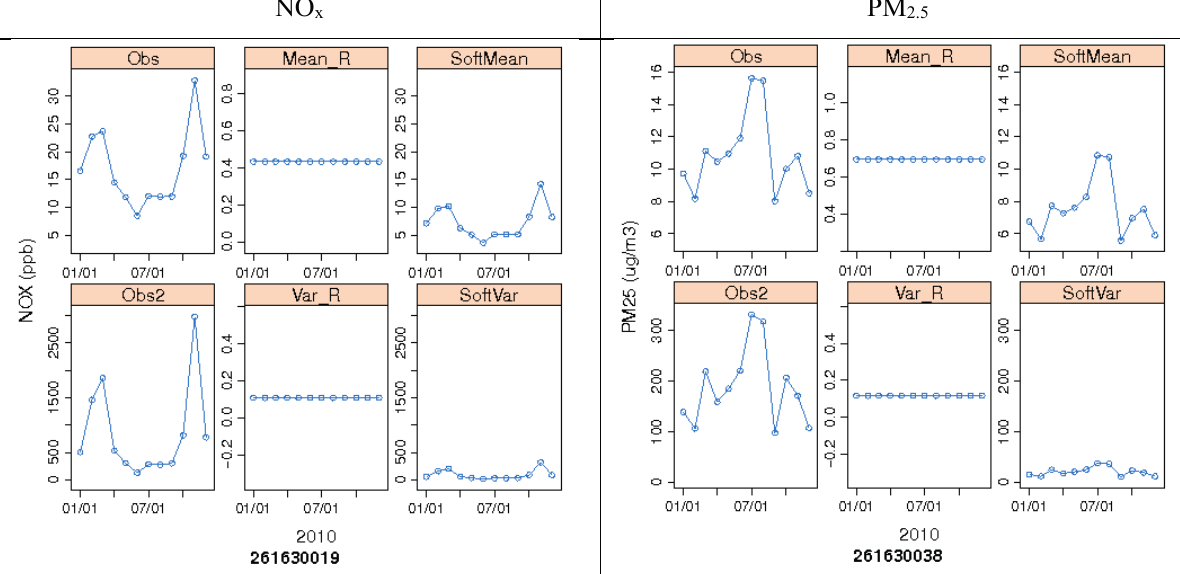
Figure 8. Observed concentration, R ZeroOut/Total mean, R ZeroOut/Total variance, soft mean, and soft variance averaged monthly at nonbackground monitors 261630019 (E 7 Mile Rd) for NO x and 261630038 (Newberry) for PM 2.5 . NO x